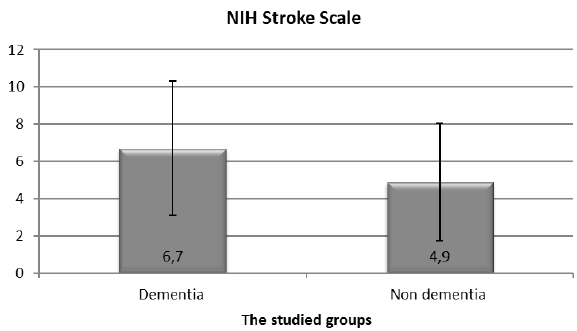
Figure 1. National Institute Health Stroke Scale among patients and